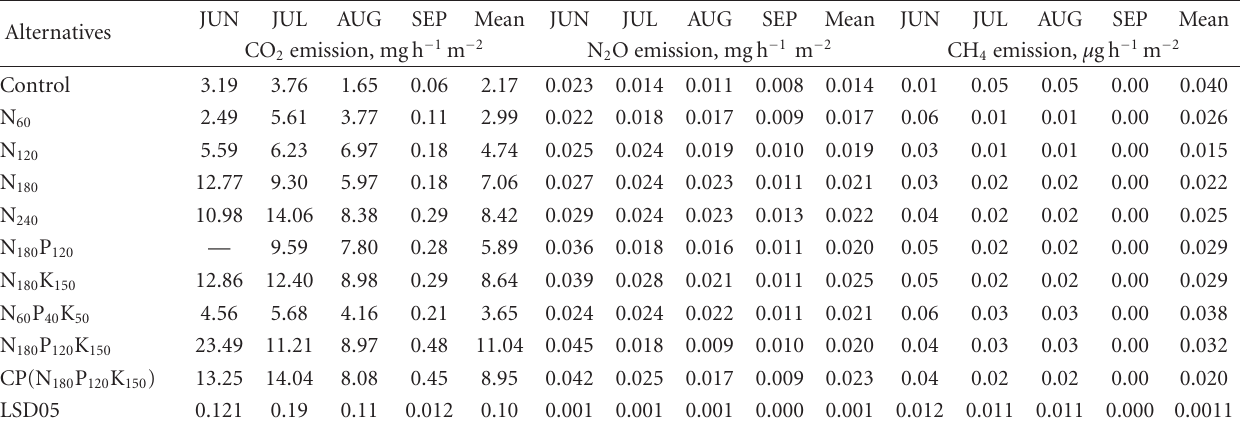
Table 3: Microgas emission in fertilized and di ff erently managed grasslands (seminatural and CP-cultural pasture) during vegetation period.